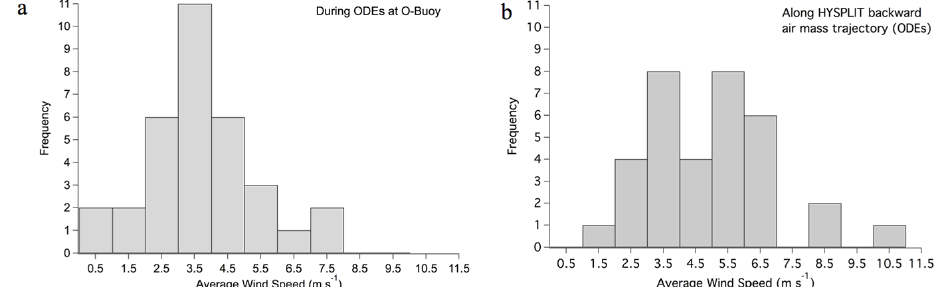
Figure 12. (a) Histogram of the average wind speed measured by the O-Buoys during ODEs. (b) Histogram of average wind speeds from O 3 -depleted air masses, as determined from the HYSPLIT backward air mass